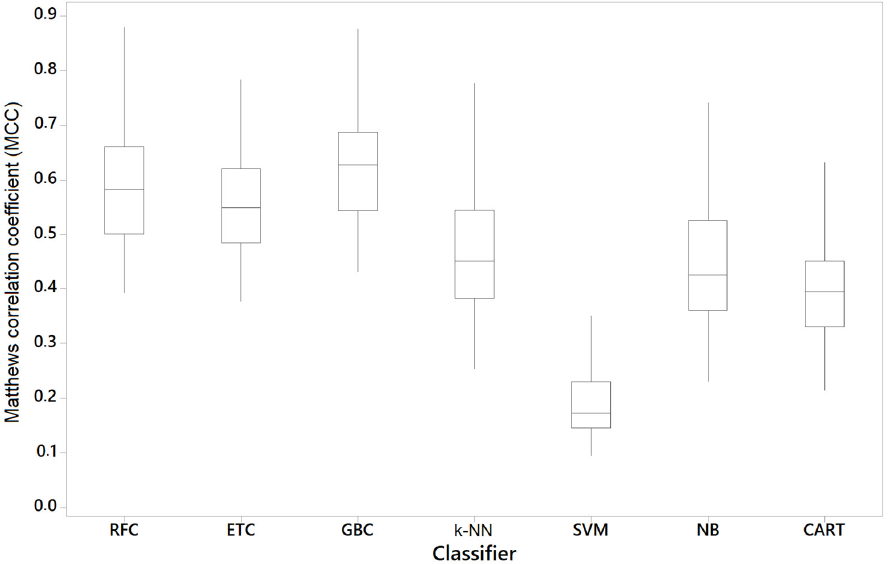
Figure 4. Boxplot of Matthews correlation coefficient of ML classifiers for the CA problem.